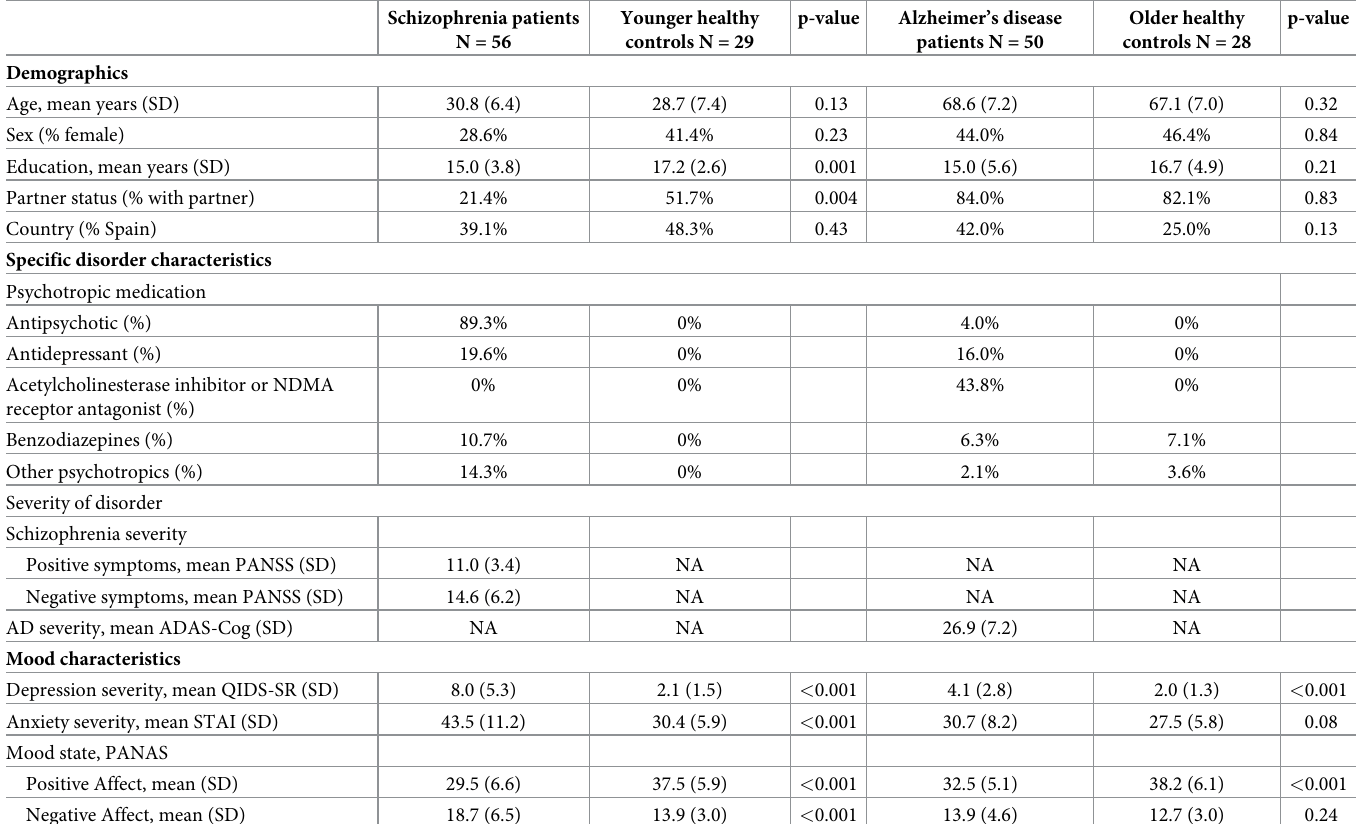
Table 1. Baseline characteristics (N = 163) across patient and control